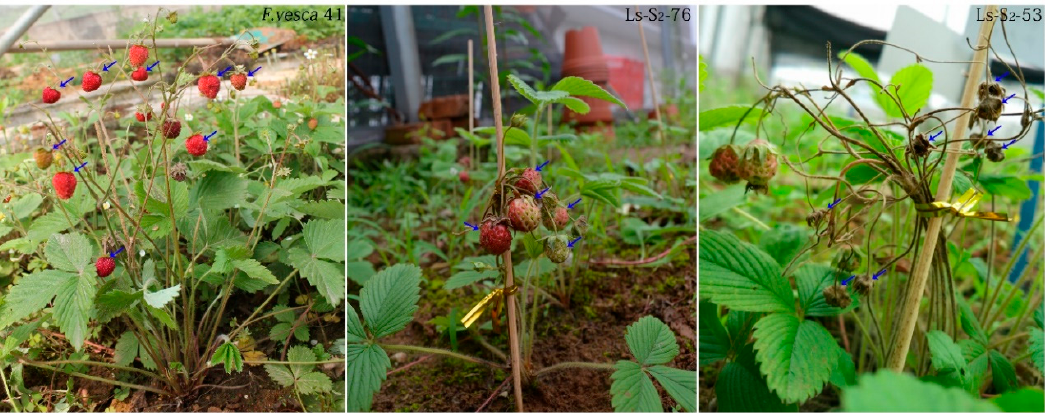
Figure 1. The field performances of F. vesca 41, Ls-S 2 -53, and Ls-S 2 -76. Arrows mark the growing condition of fruit for 25 days after manual self-pollination.